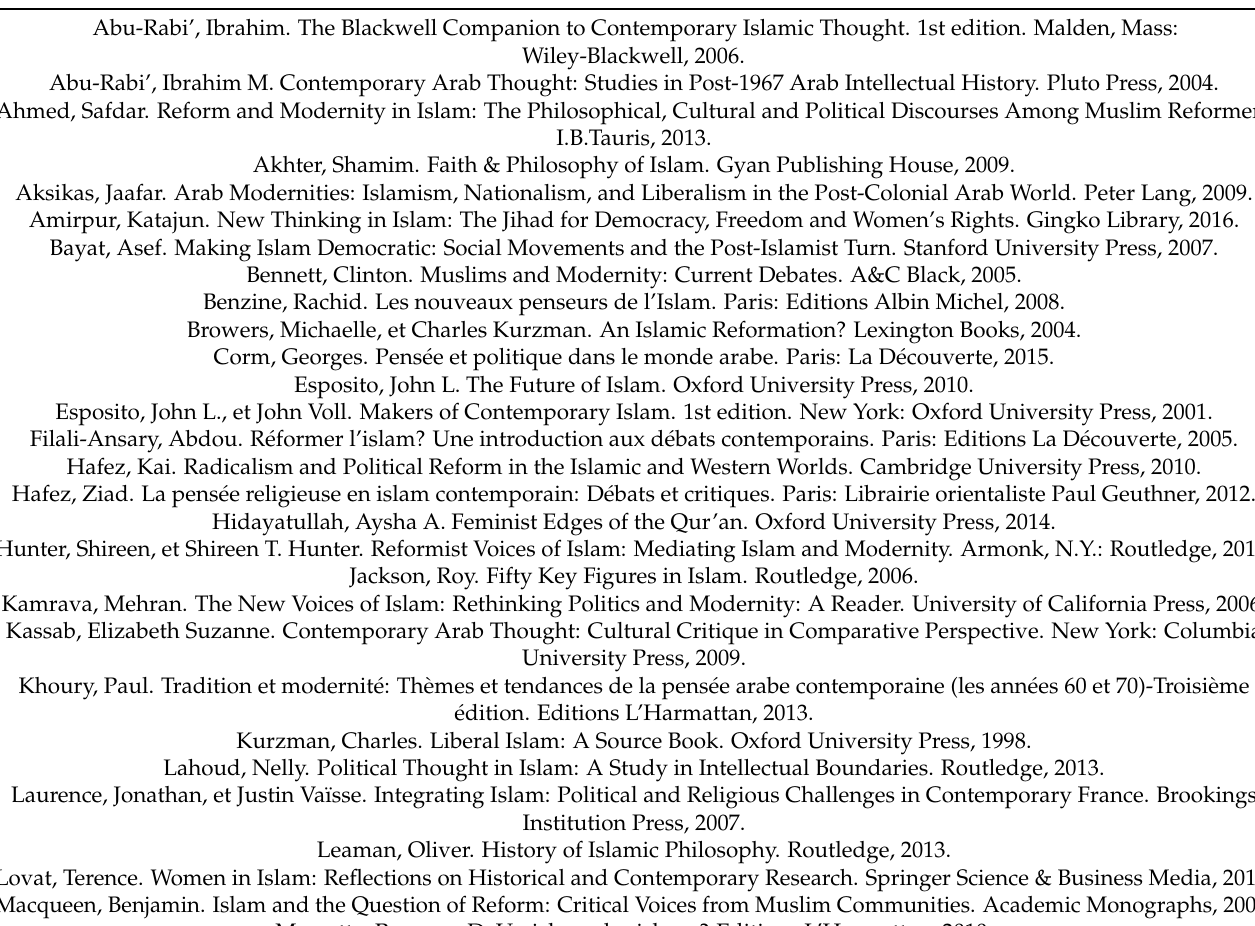
Table 1. 40 Books Collected to Select our Study